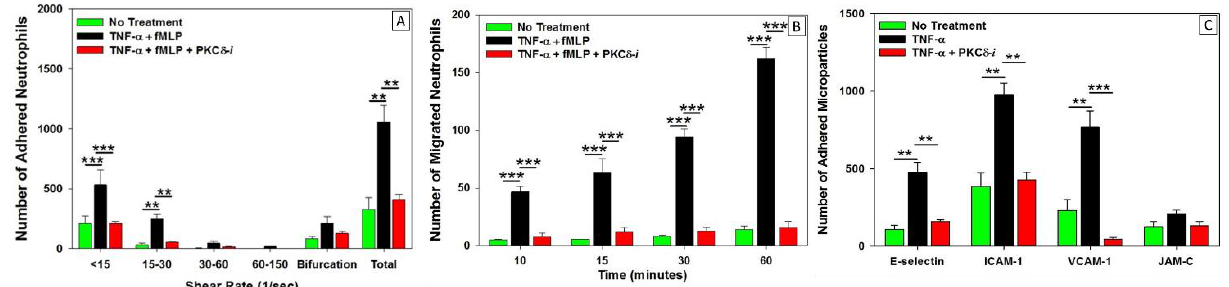
Figure 4. In vitro neutrophil migration in response to inflammation: regulation by PKCδ: ( A ) TNF-α treatment significantly increased human neutrophil adhesion to human pulmonary microvascular endothelial cells, which was inhibited following treatment with the PKCδ inhibitor. Neutrophil adhesion occurred preferentially at low shear rates and near bifurcations in the bMFA. ( B ) In response to fMLP, human neutrophil migration across TNFα-activated endothelial cells was significantly increased compared to untreated cells. Treatment with the PKCδ inhibitor reduced migration to untreated levels. ( C ) TNFα treatment increased the expression of the adhesion molecules, E-selectin, ICAM-1, and VCAM-1, but not JAM-C, indicating selective regulation. PKCδ inhibitor treatment significantly decreased E-selectin, ICAM-1, and VCAM-1, but not JAM-C expression. (Reproduced with permission from reference [47]) ( n = 4 for panel A and B, n = 3 for panel C, data is presented as Mean ± SEM, one-way ANOVA, ** p < 0.01, and *** p < 0.001).